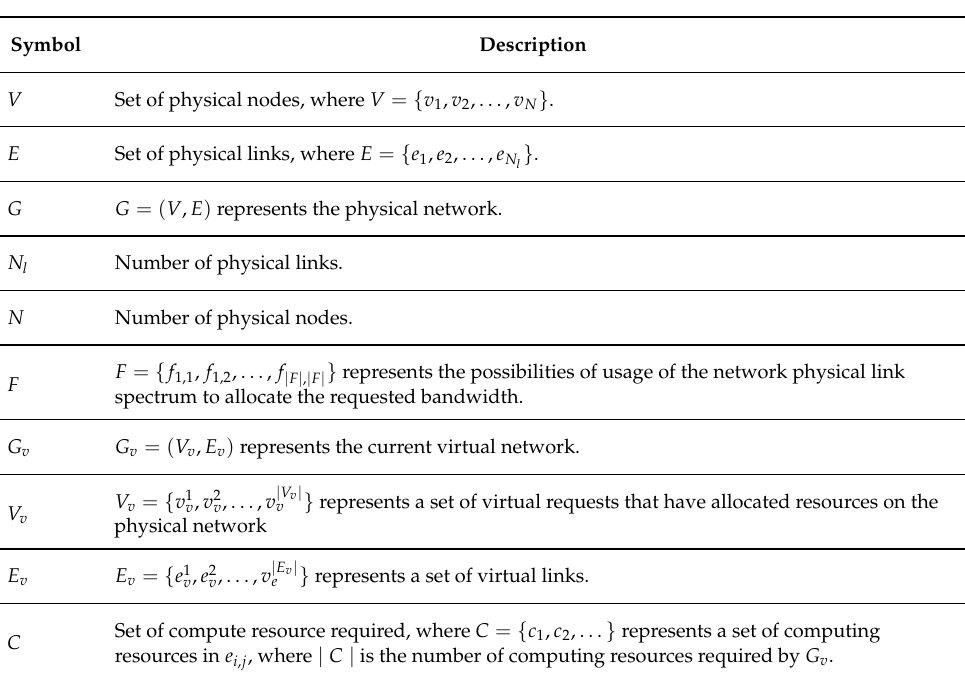
Table 2. Notation used in the paper.